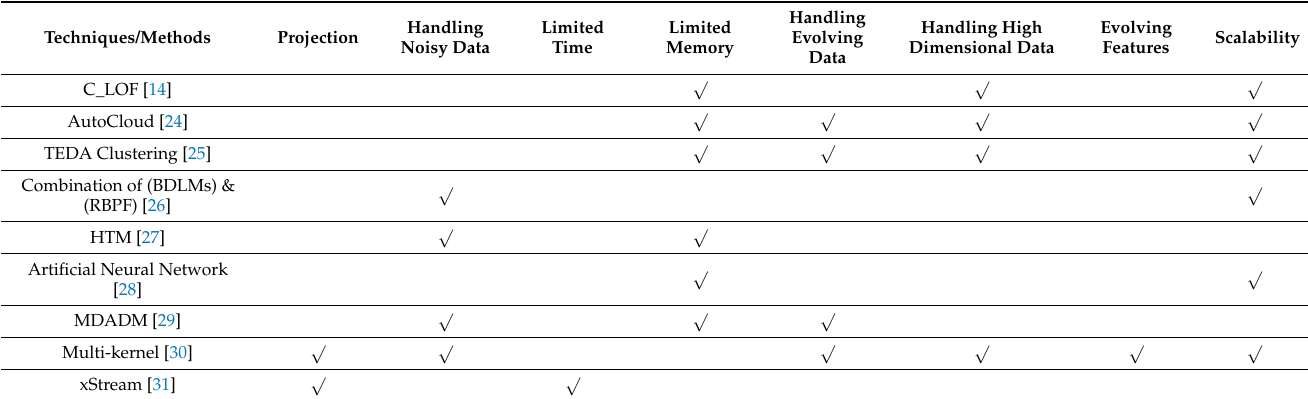
Table 4. Anomaly detection techniques